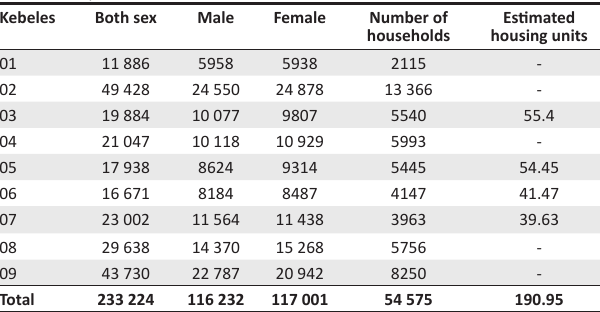
TABLE 1: Population and households for each kebele in Dire